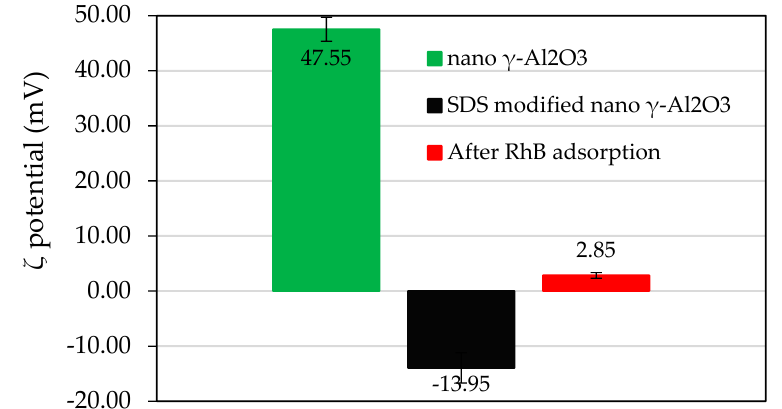
Figure 11. The ζ potential of synthesized nano γ -Al 2 O 3 , SDS modified nano γ -Al 2 O 3 (SMNA), and SMNA after RhB adsorption in 1 mM NaCl (pH 4).